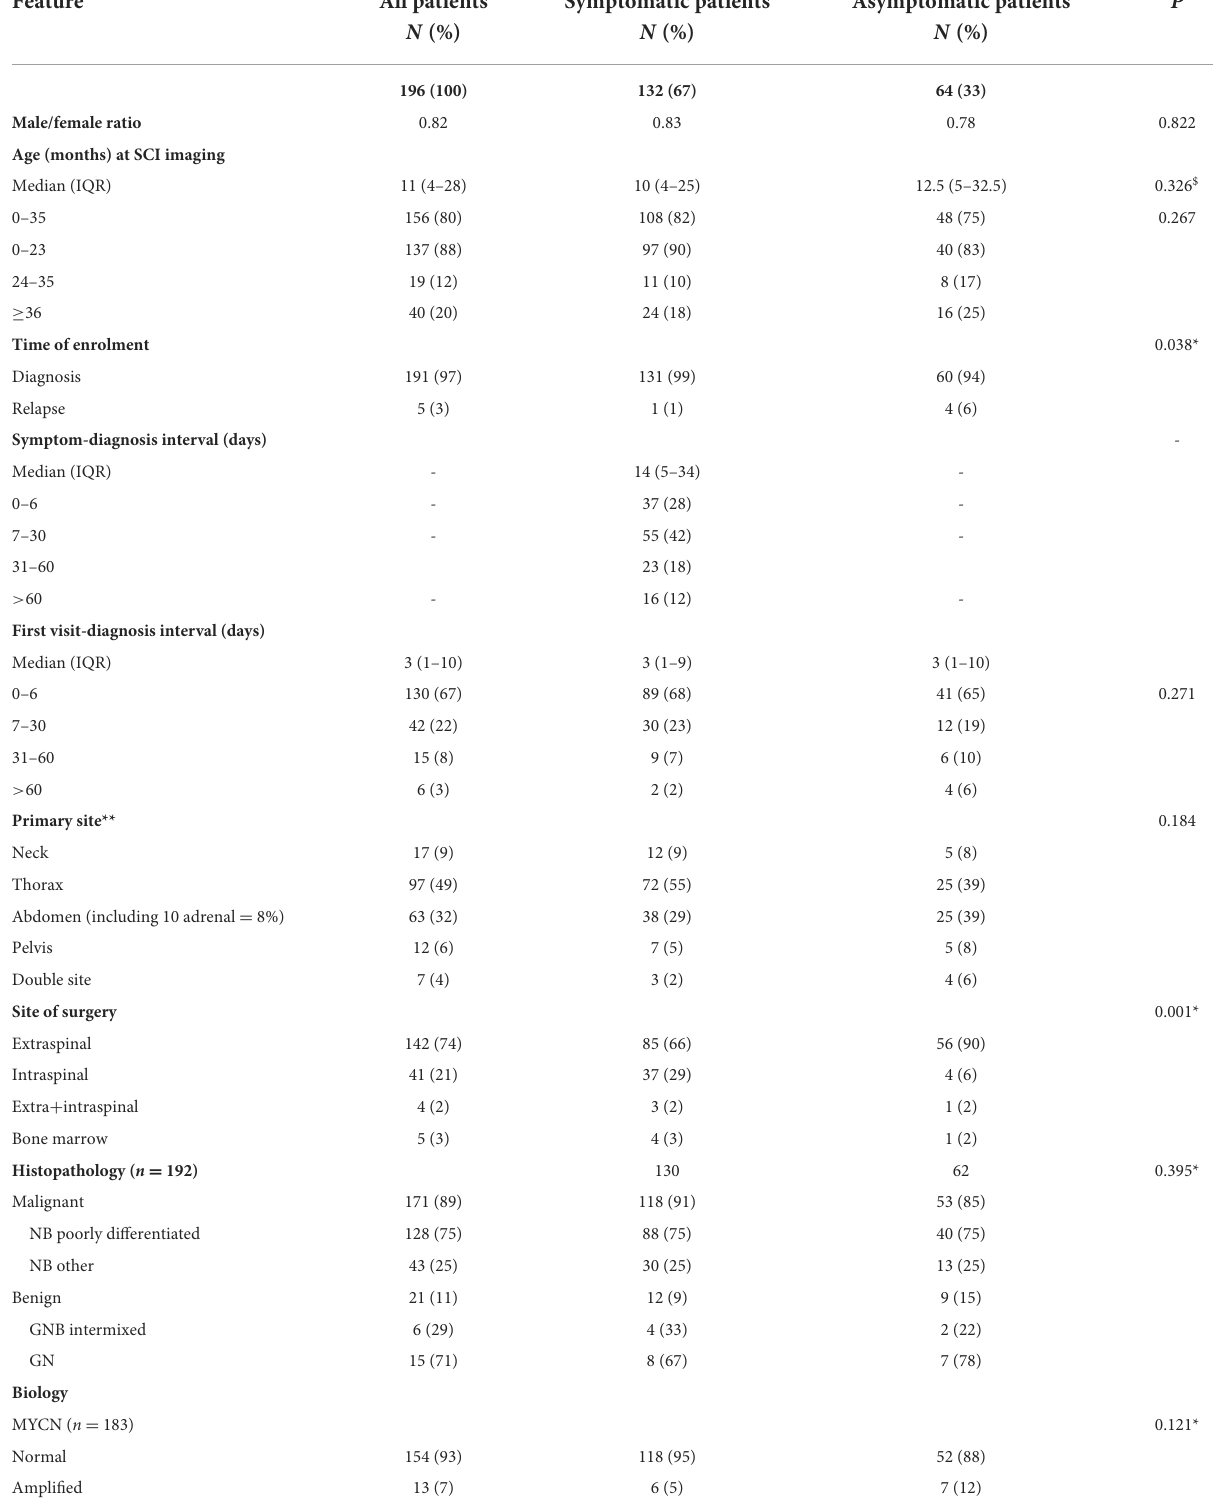
TABLE 2 Presenting features of 196 NB-SCI